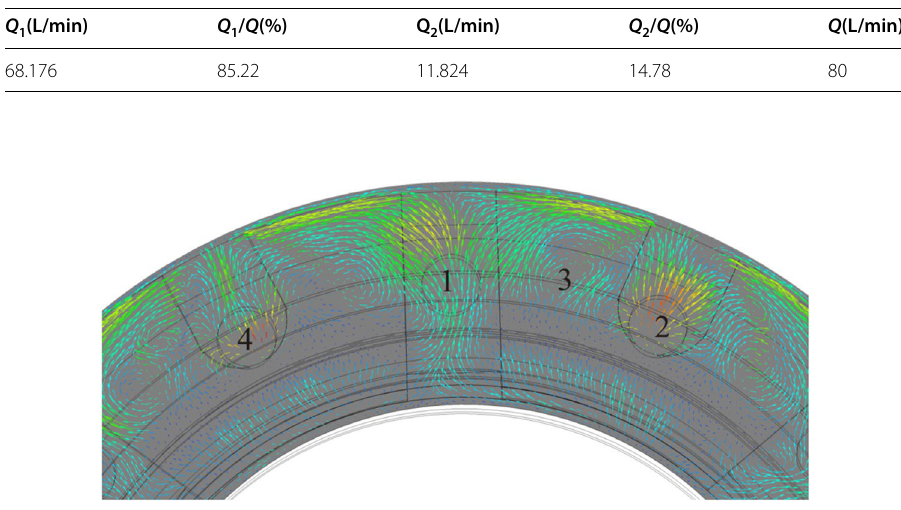
Fig. 6 Bottom nozzles vector diagram. 1 Main nozzle, 2 right assistant nozzle, 3 cutting teeth, and 4 left assistant